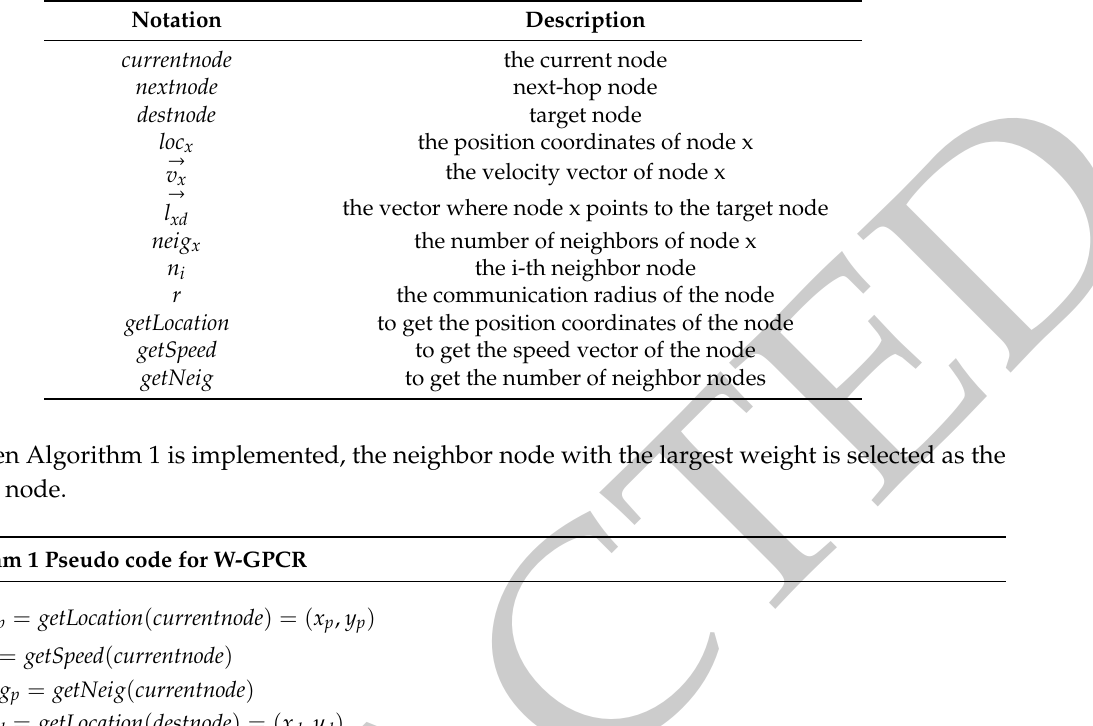
Table 1. The notations in Algorithm 1.